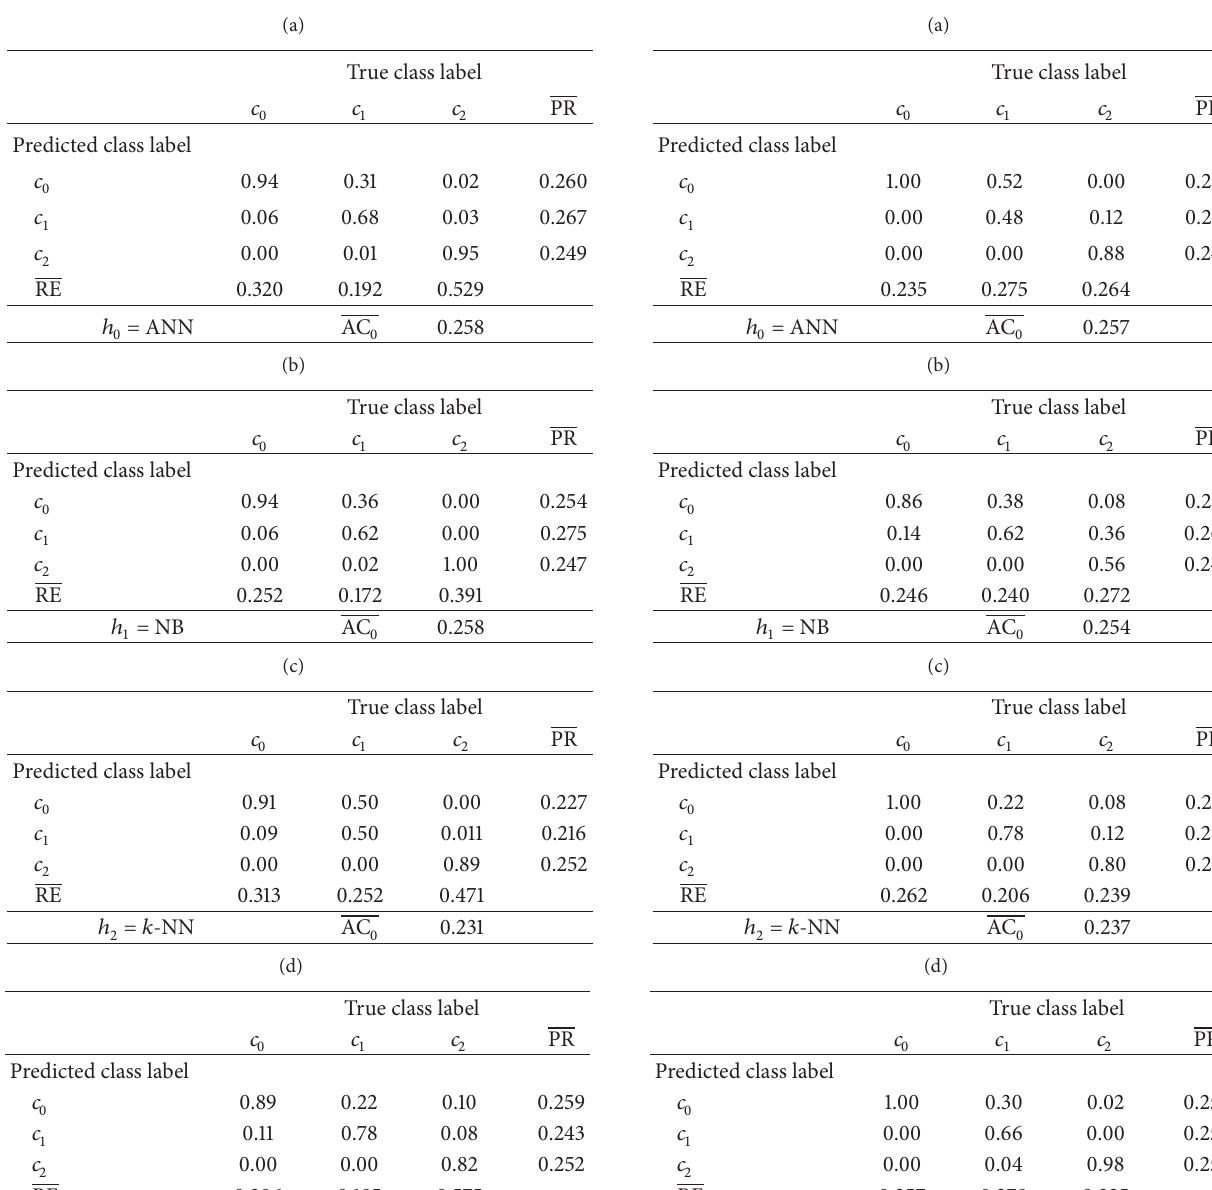
Table 4: Confusion matrix for noisy data (SNR = 5 dB). Table 5: Confusion matrix for noisy data (SNR =